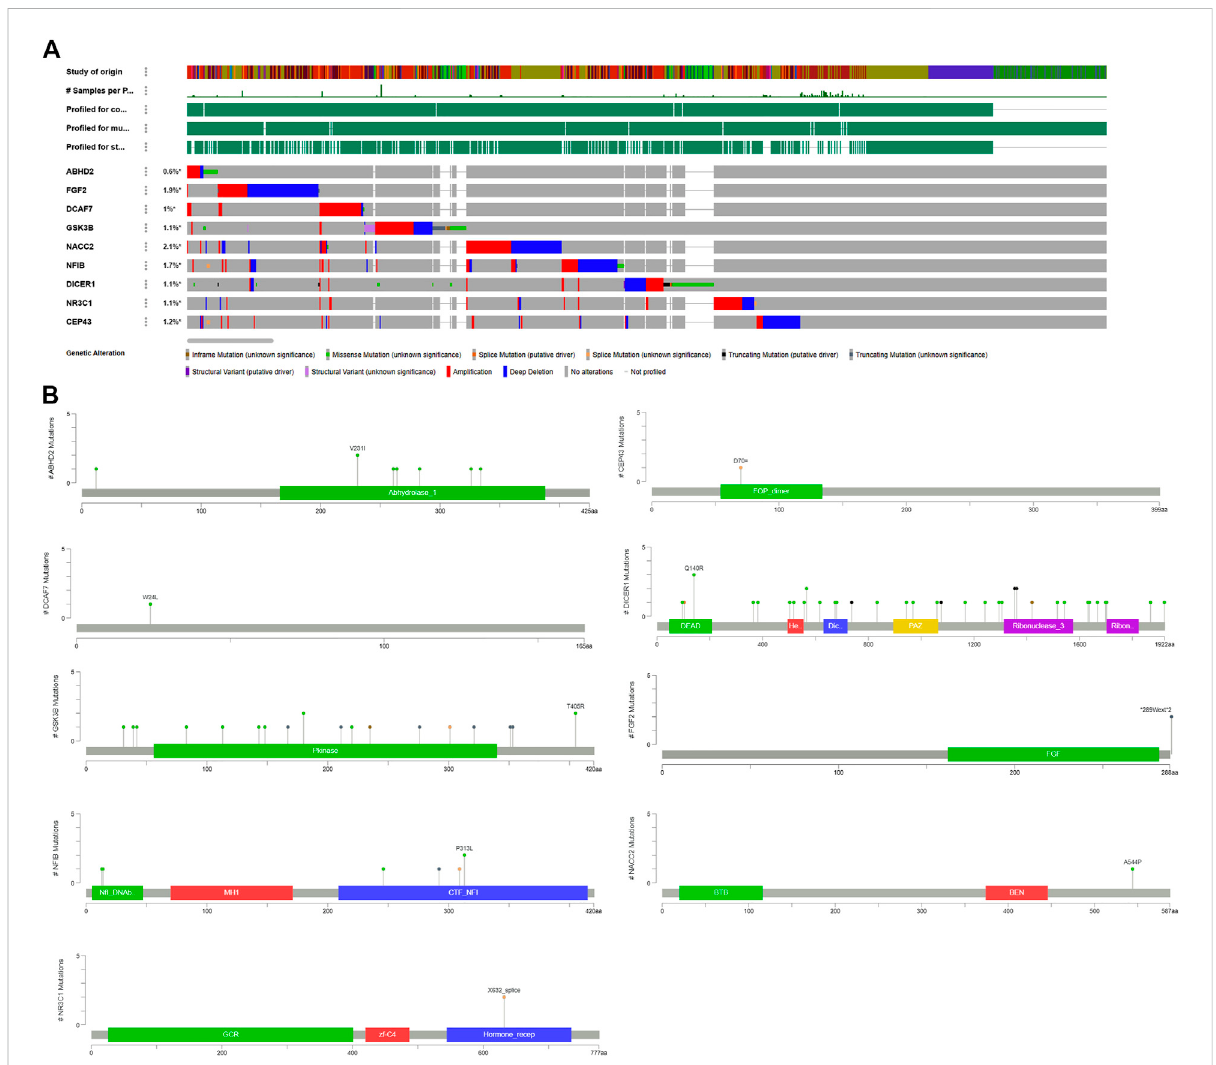
FIGURE 4 Mutation load of hub genes. (A) Distribution and frequency of genetic alternations in PC hub genes. (B) The “ lollipop ” plot generated by the MutationMappertoolofcBioPortalshowstheopenboxoftheninehubgenes,aswellasthefrequency,position,andthedomainofmutationsinthe